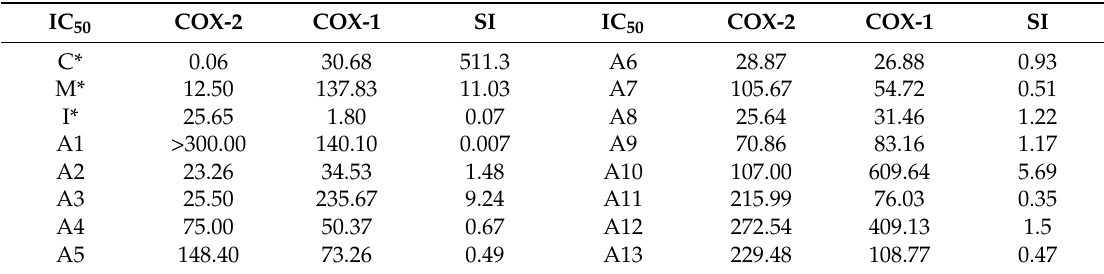
Table 1. Experimental IC 50 ( µ M) against COX-1 and COX-2 for compounds A1 – 13